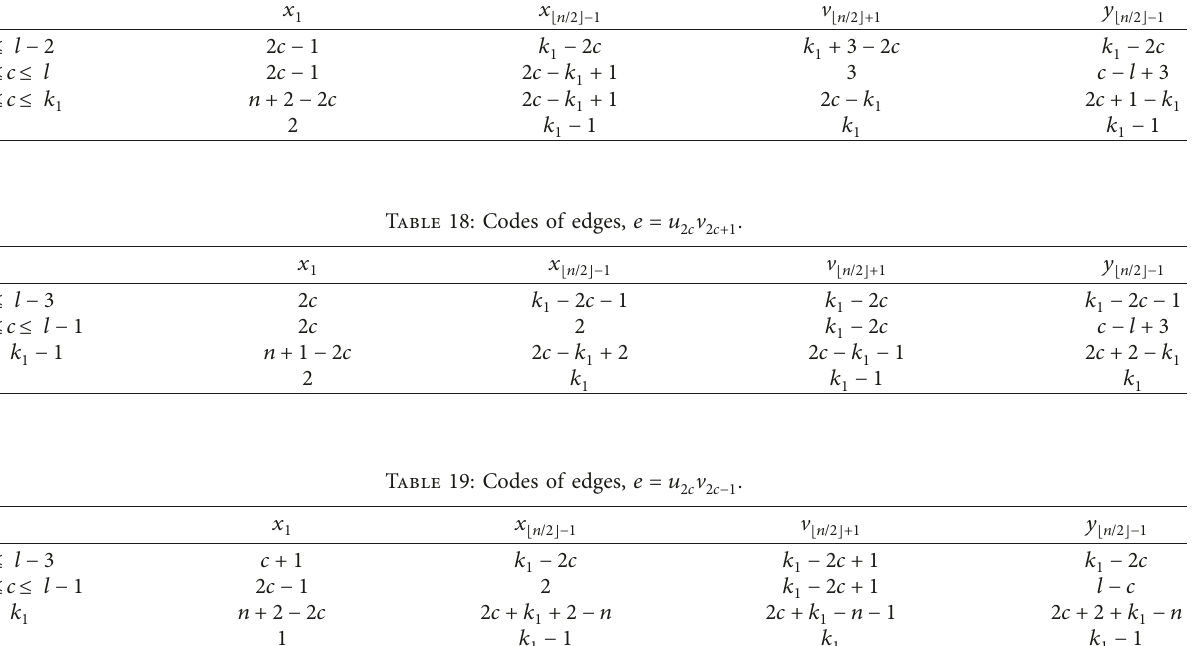
Table 17: Codes of edges, e � u